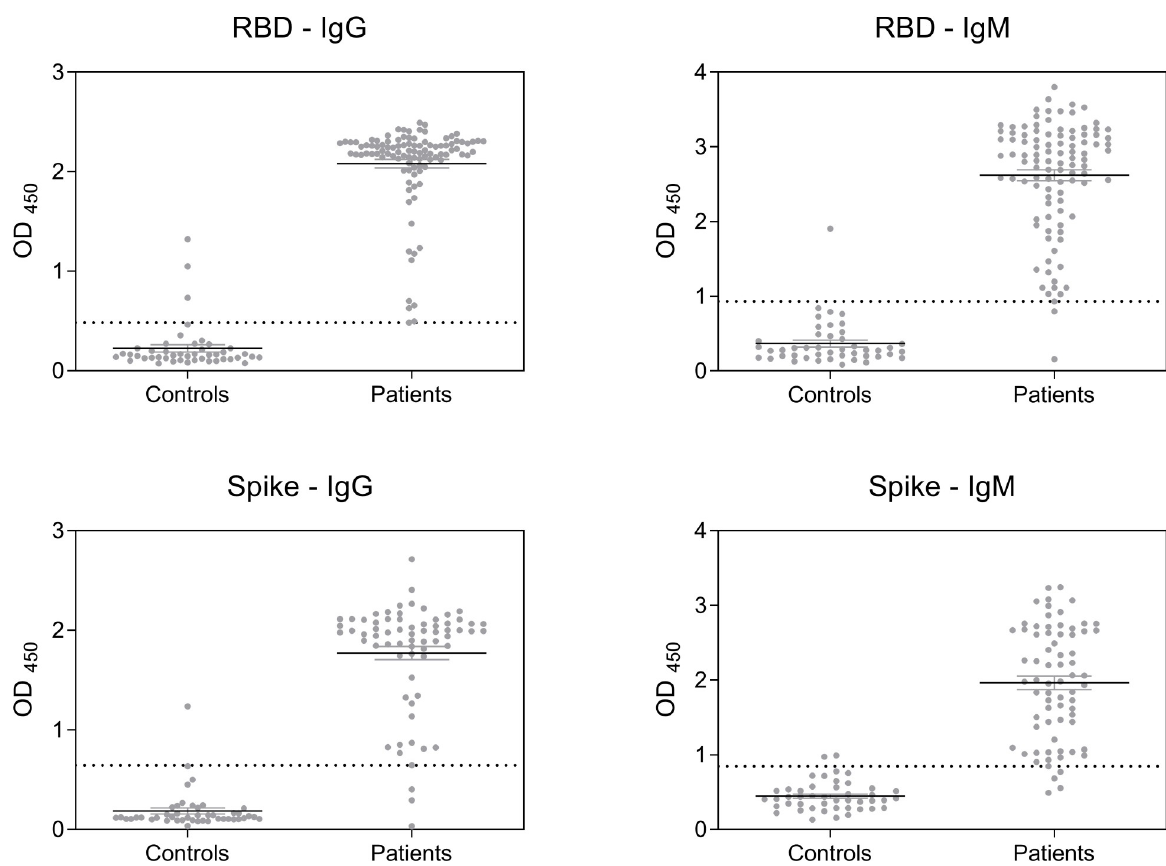
Fig 1. Serum reactivity of COVID-19 patients and pre-pandemic controls at each ELISA. RBD: recombinant spike receptor binding domain. Spike: recombinant full Spike protein. Samples were processed as described in Materials and Methods. Dotted lines show the optimal cutoff for each ELISA test as determined by ROC analysis (Table